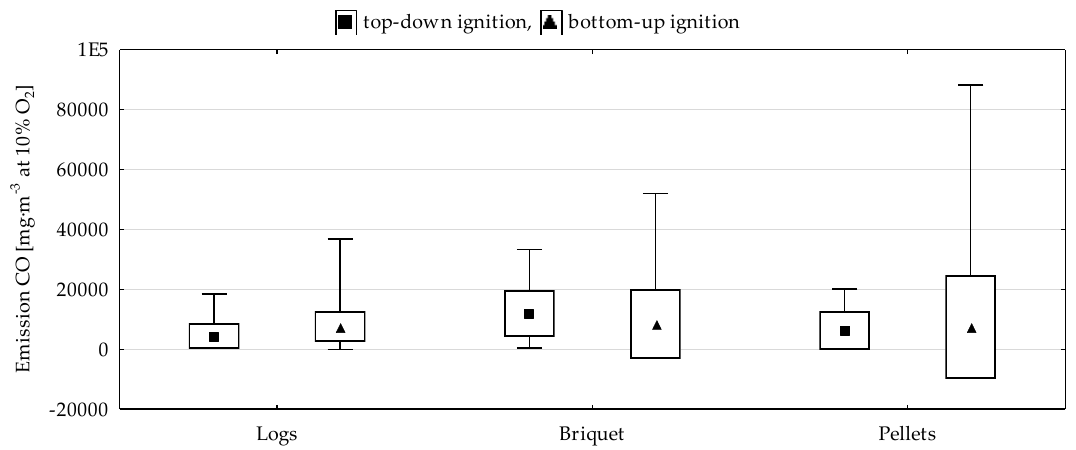
Figure 2. Indicators of carbon monoxide emission during the combustion of the selected biomass forms.